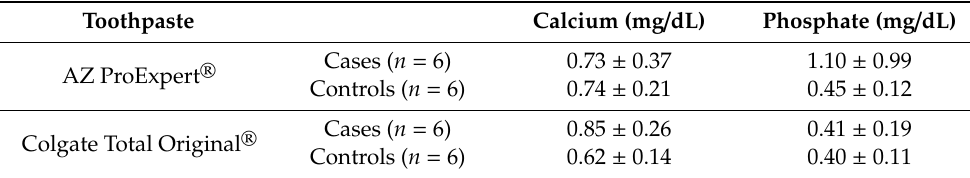
Table 3. Enamel samples in lactic acid solution.